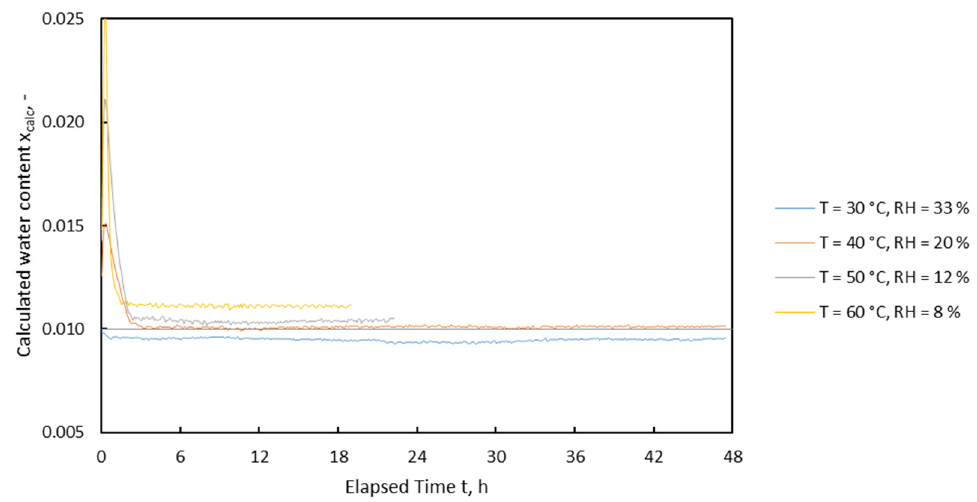
Figure 10. Calculated water content vs. time; calculated water content of air during drying of fresh nettles with different temperatures in the HPD TP3+; x set = 0.01, v set = 0.2 m·s − 1 .